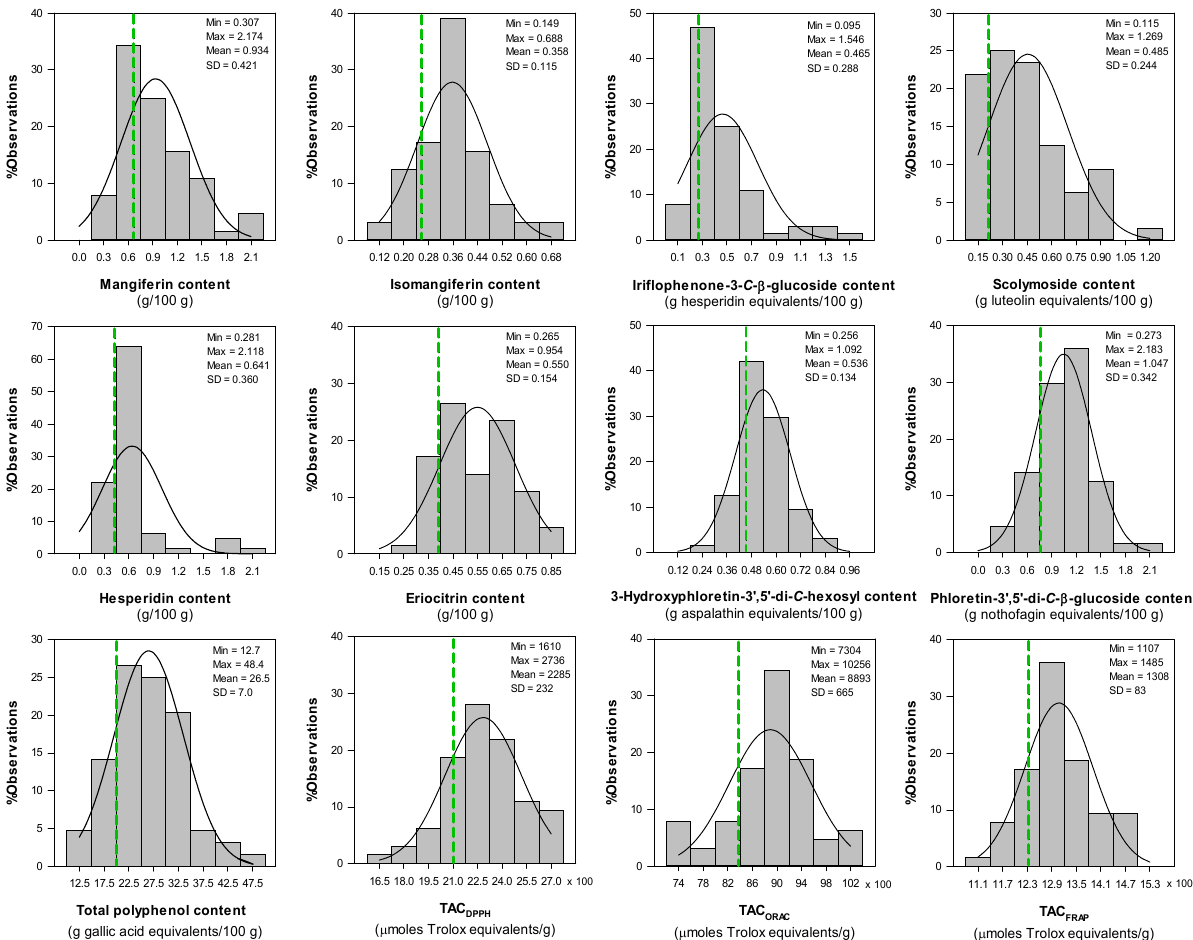
Figure 6. Distribution of phenolic composition and total antioxidant capacity (TAC) of freeze-dried aqueous extracts of green Cyclopia subternata (n = 64) [dotted green line indicates the 20%